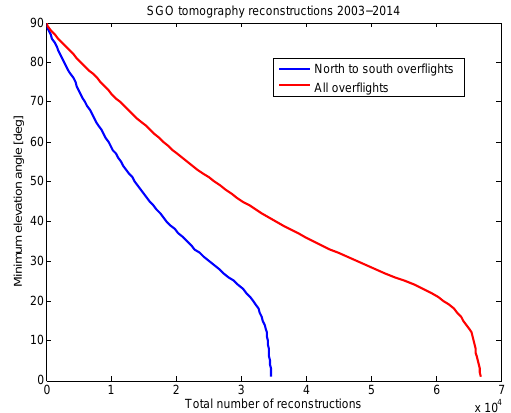
Figure 4. The number of satellite overflights over the whole obser- vation period with respect to minimum threshold